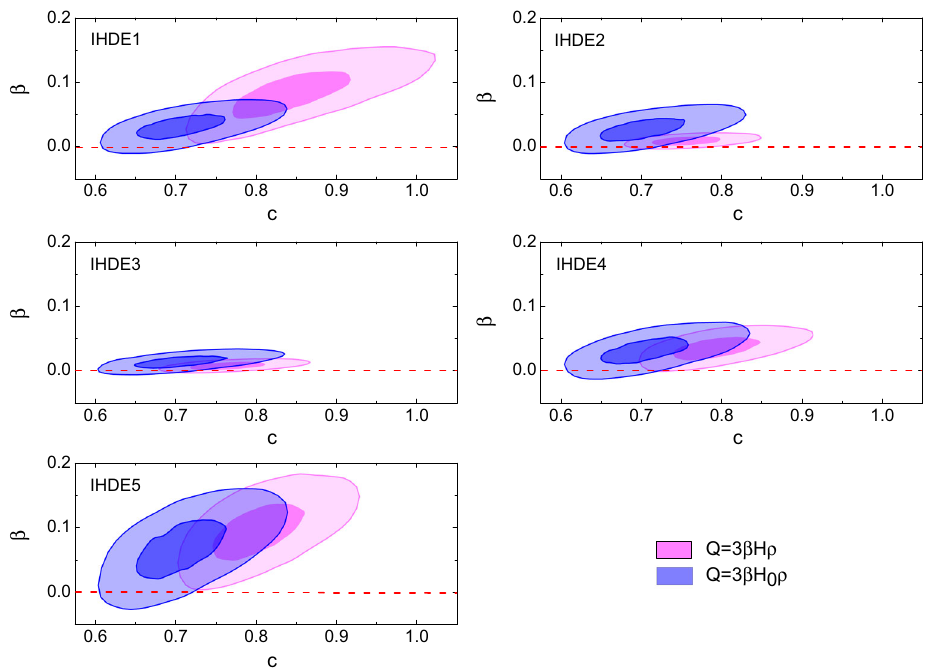
Fig. 4 The SN + CMB + BAO + H 0 constraints on the IHDE models. The 68.3 and 95.4% confidence level contours are shown in the c – β plane. The red dashed line denotes the case of β = 0